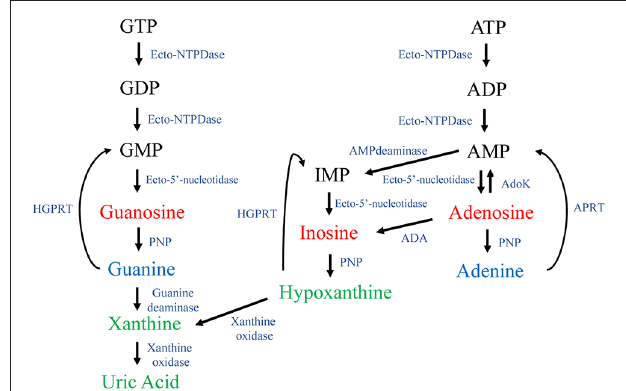
FIGURE 1 | Purine metabolism. The guanine nucleotides guanosine-5 (cid:48) -triphosphate (GTP), guanosine-5 (cid:48) -diphosphate (GDP) and guanosine-5 (cid:48) -monophosphate (GMP) are sequentially dephosphorylated by ecto-nucleotidases (i.e., Ecto-NTPDase and Ecto-5’-nucleotidase), thus generating guanosine. Guanosine is hydrolyzed by PNP generating the purine base guanine. By action of a guanine deaminase (GDA), guanine is converted into xanthine and subsequently to uric acid by the action of a xanthine oxidase. Adenine nucleotides are also hydrolyzed forming the nucleosides adenosine and inosine. The following nitrogenous bases, hypoxanthine, xanthine and uric acid, are formed intracellularly. Ecto-NTPDase, ecto-nucleotide diphosphohydrolase or apyrase; ADA, adenosine deaminase; AdoK, adenosine kinase; APRT, adenine phosphoribosyl transferase; HGPRT, hypoxanthine-guanine phosphoribosyl transferase; PNP, purine nucleoside phosphorylase. APRT and HGPRT are mainly involved in the intracellular salvage purines